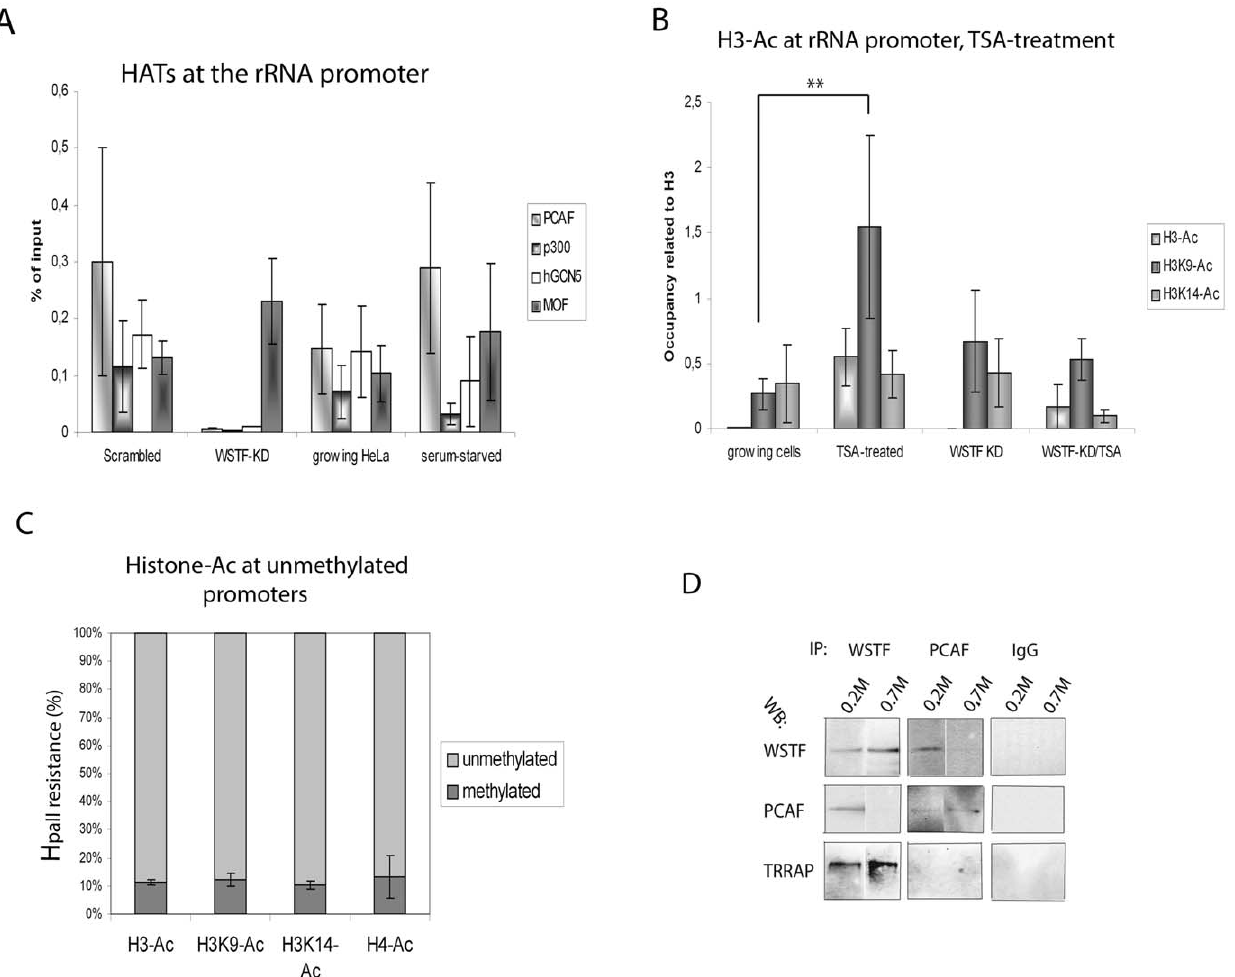
Figure 5. WSTF allows for the association of several HATs with rRNA promoters. ( A ) ChIP of scrambled control cells, WSTF KD cells, growing cells and serum-starved cells with the antibodies indicated and PCR signals were measured at the rRNA gene promoter. The values are presented as percentages of the input signal. Error bars represent standard deviations from four separate experiments. ( B ) ChIP of growing cells, TSA- treated cells (4 hours), WSTF KD cells and WSTF KD cells treated with TSA (4 hours) using the antibodies indicated. The signals have been adjusted to the signal from histone H3 in each experiment. Error bars represent standard deviations from four separate experiments. **: p-value=0.0036 (Student t-test, two-sample equal variance). ( C ) HpaII and MspI digestion of DNA from ChIPs precipitated with antibodies against H3-Ac, H3K9-Ac, H3K14-Ac and H4-Ac. The degree of methylation was correlated to the level of PCR product produced with a primer pair over the promoter. 100% represents 100% methylated promoter DNA, 0% represents the level observed in digestions with MspI. ( D ) Immunoblot (10% SDS-PAGE) of immunoprecipitations using antibodies against WSTF and PCAF, as indicated, of nuclear extracts prepared at 0.2 M KCl and 0.7 M KCl. Co- immunoprecipitated proteins were detected with the antibodies marked at the left. IgG was used as a